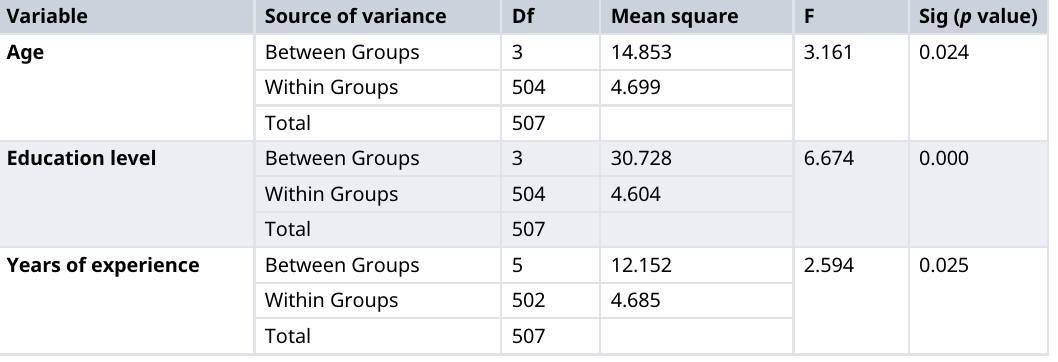
Table 6. Sociodemographic variables ’ association with pharmacy practitioners ’ overall knowledge on herbal product-cardiovascular drugs interaction. Variable